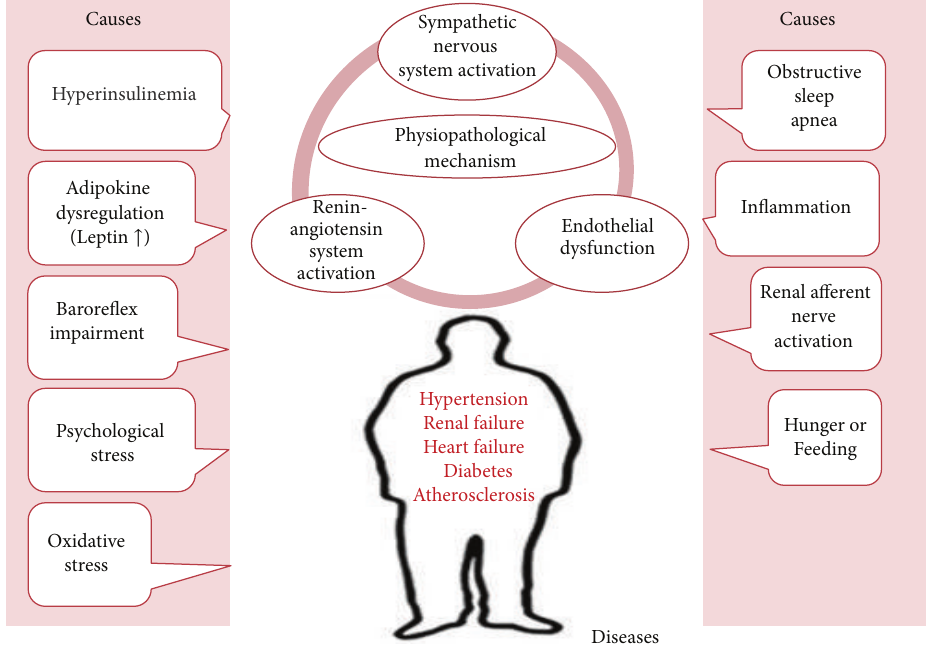
Figure 1: In obesity, infiltration of inflammatory cells in the white adipose tissue disturbs the secretion of adipokines and increases the activity of adipocyte renin-angiotensin system. Increased secretion of leptin and proinflammatory cytokines and decreased amounts of adiponectin contribute to the development of obesity-related